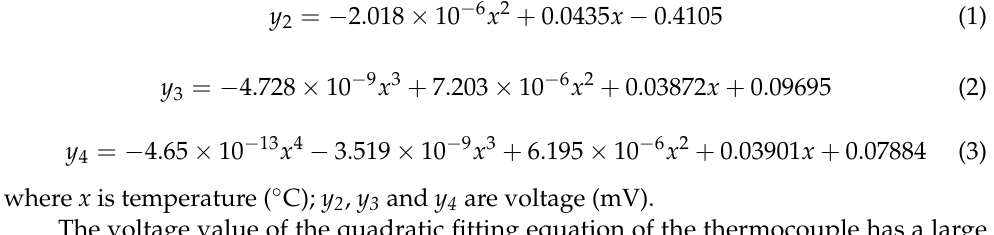
( b ) Figure 5. FE simulation. ( a ) FE models of the insert and workpiece, ( b ) Simulation process. Table 2. Parameters of tool and workpiece materials. Name